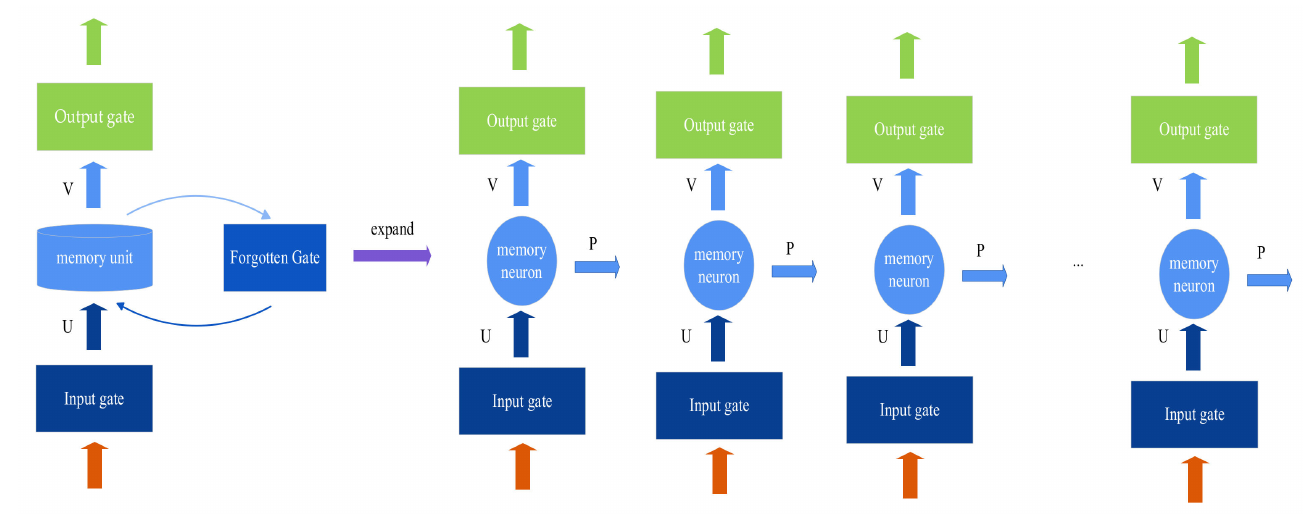
Figure 12. Structure diagram of cyclic neural